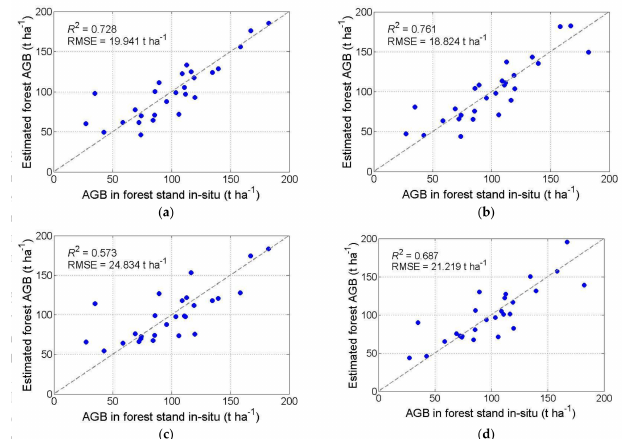
Figure 10. Comparison between in-situ AGB and estimated forest AGB derived from model in 314 deg. flight direction ( a ) H ac 3, ( b ) H ac 8, ( c ) TomoH 1, and ( d ) TomoH